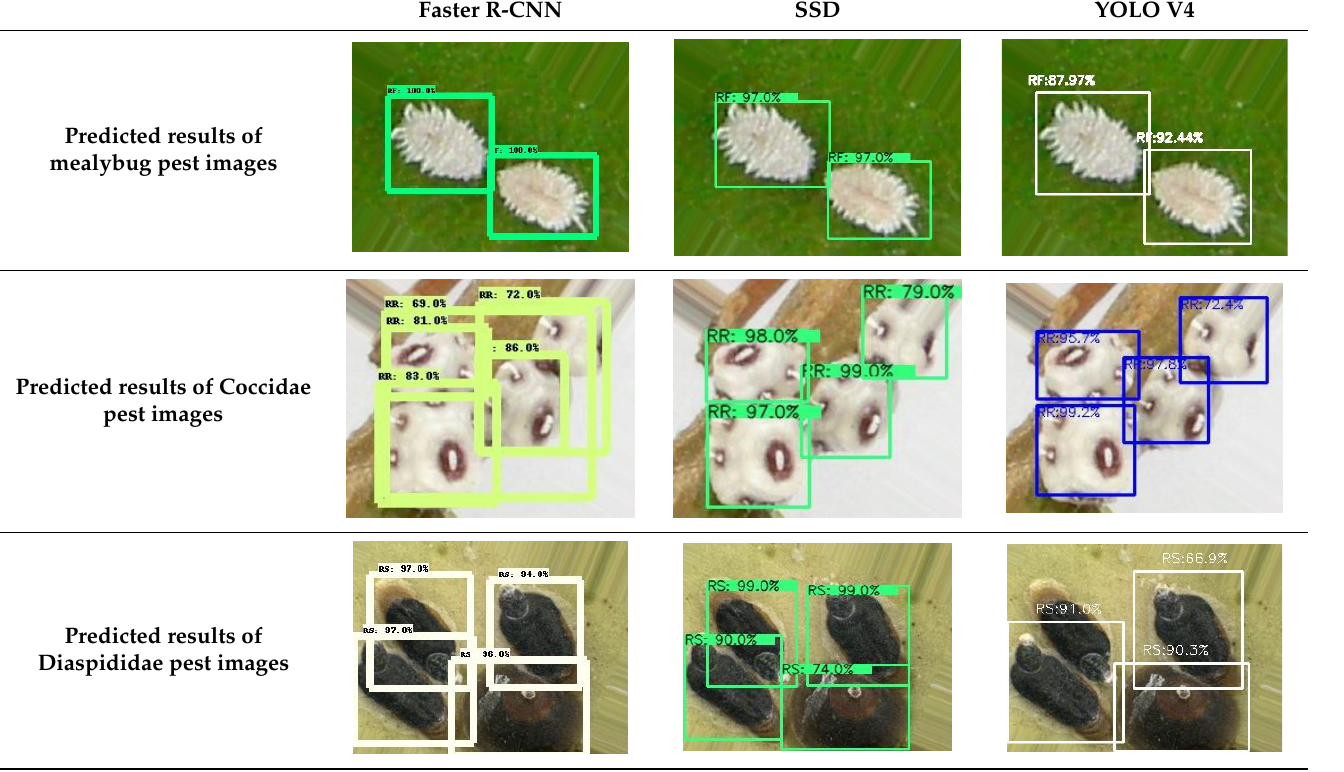
Table 3. A few samples in the training dataset for mealybugs and Diaspididae.